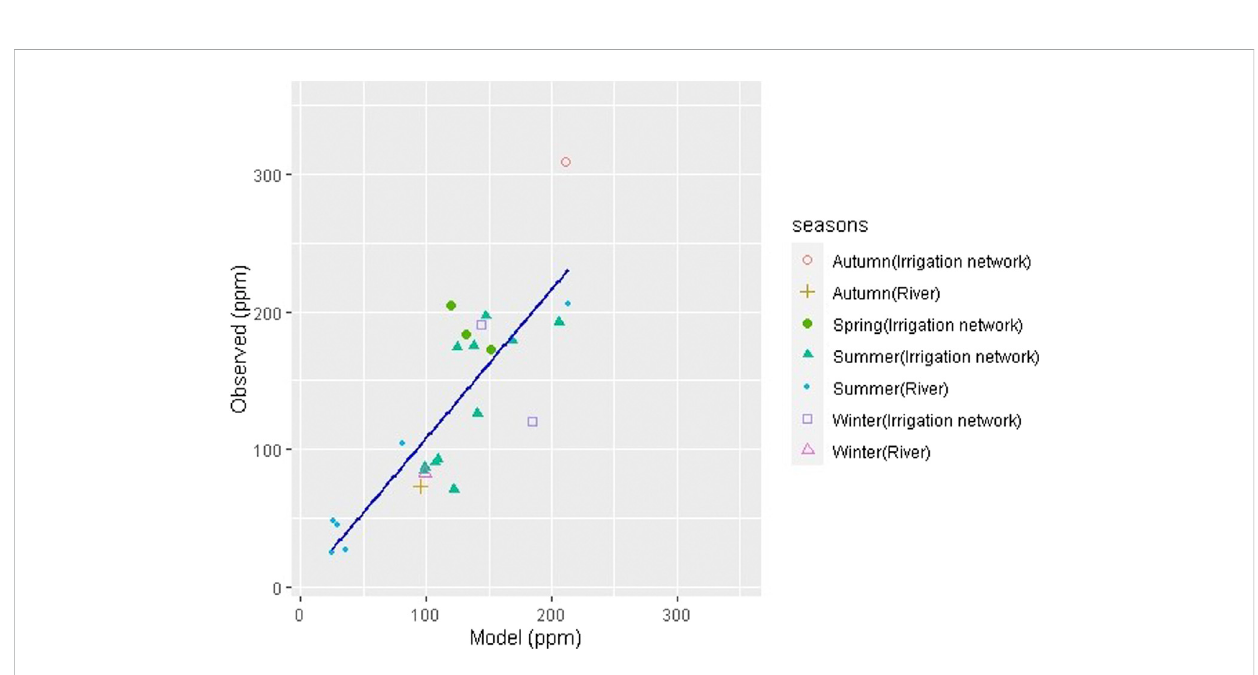
values (NATIONAL METEOROLOGICAL SERVICE, 2020).